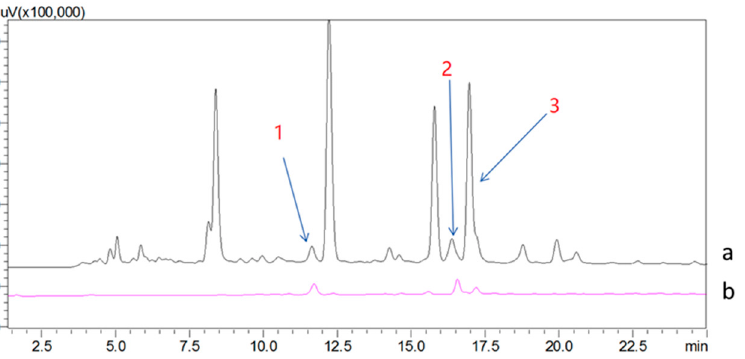
Figure 3. The chromatograms of ( a ) the A. vera extract (S 0 ) and ( b ) the 50% ACN eluent from AG-MNPs (S 5 ).